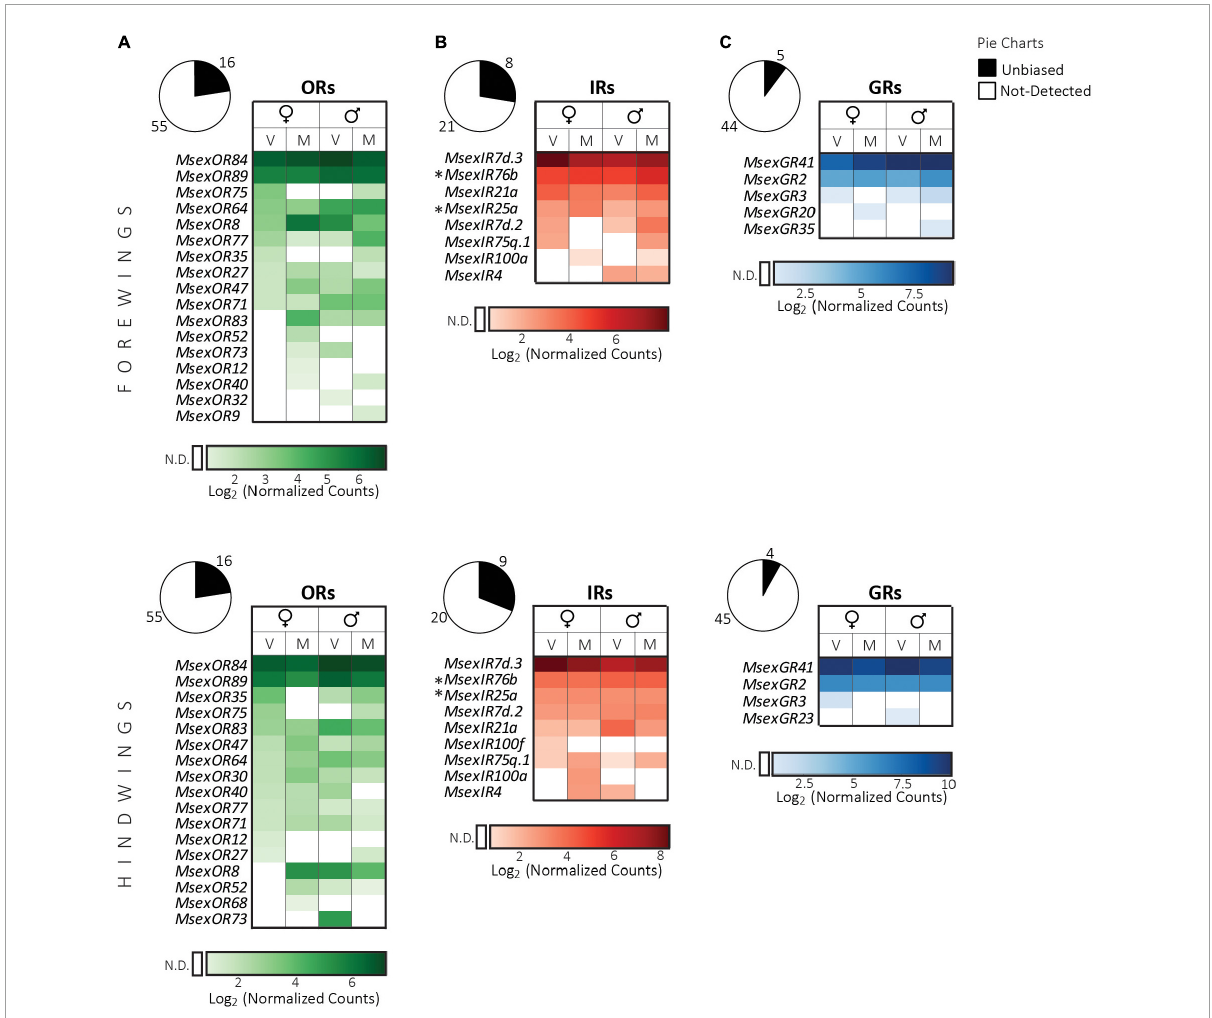
FIGURE4 Expression of chemosensory receptor genes in the wings of adult M. sexta (top panel, forewings; bottom panel, hindwings). (A) Odorant receptors, (B) ionotropic receptors, (C) gustatory receptors. Pie charts depict the percentage of expressed genes (absolute numbers next to the charts) of each receptor family (see legend on top right). Heatmaps were created separately for each receptor family using the log 2 of the geometric mean ( n = 3 biological replicates) of normalized counts obtained from the NanoString assay (see section “Materials and methods”). Light to dark shades indicate low to high counts (see color bar at bottom of each heatmap); white cells indicate no detection (N.D.) of transcripts (for a definition see section “Materials and methods”). Columns represent female and male moths of different mating states (V: virgin, M: mated). Rows represent receptors that were expressed in the wings of at least one of the four groups, and are sorted first according to values in virgin females, followed by mated females, virgin males and mated males. Symbols next to receptor gene names: ∗ , OR or IR co-receptors. Sex or mating states of males and females did not have a significant effect on receptor gene expression (FDR corrected p > 0.05, nested